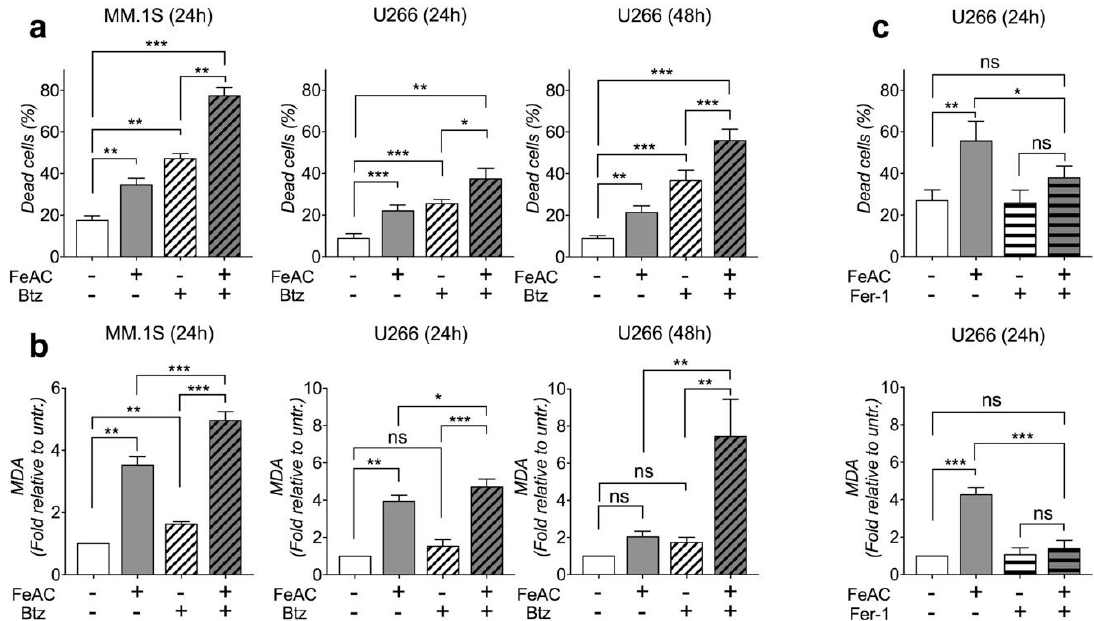
Figure 1. Iron triggers cell death by inducing lipid damage. ( a , b ) MM.1S and U266 cell lines were